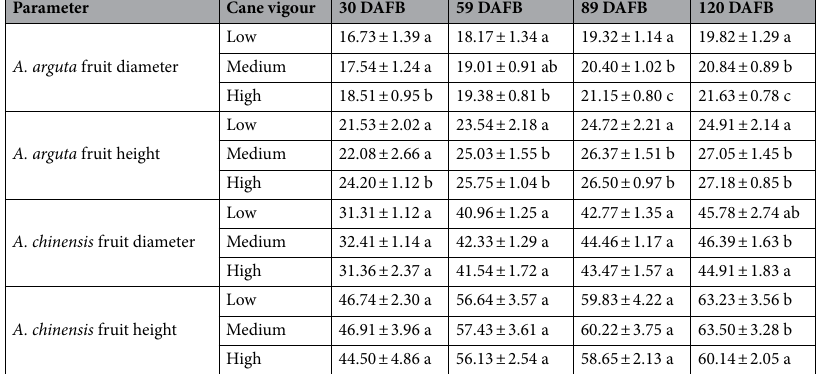
Table 2. Measured height and diameter (mean ± SE, in mm) of fruit in 1-month interval (shown in days after full blooming (DAFB)). Mean values followed by the same letter within a marked column do not differ significantly.